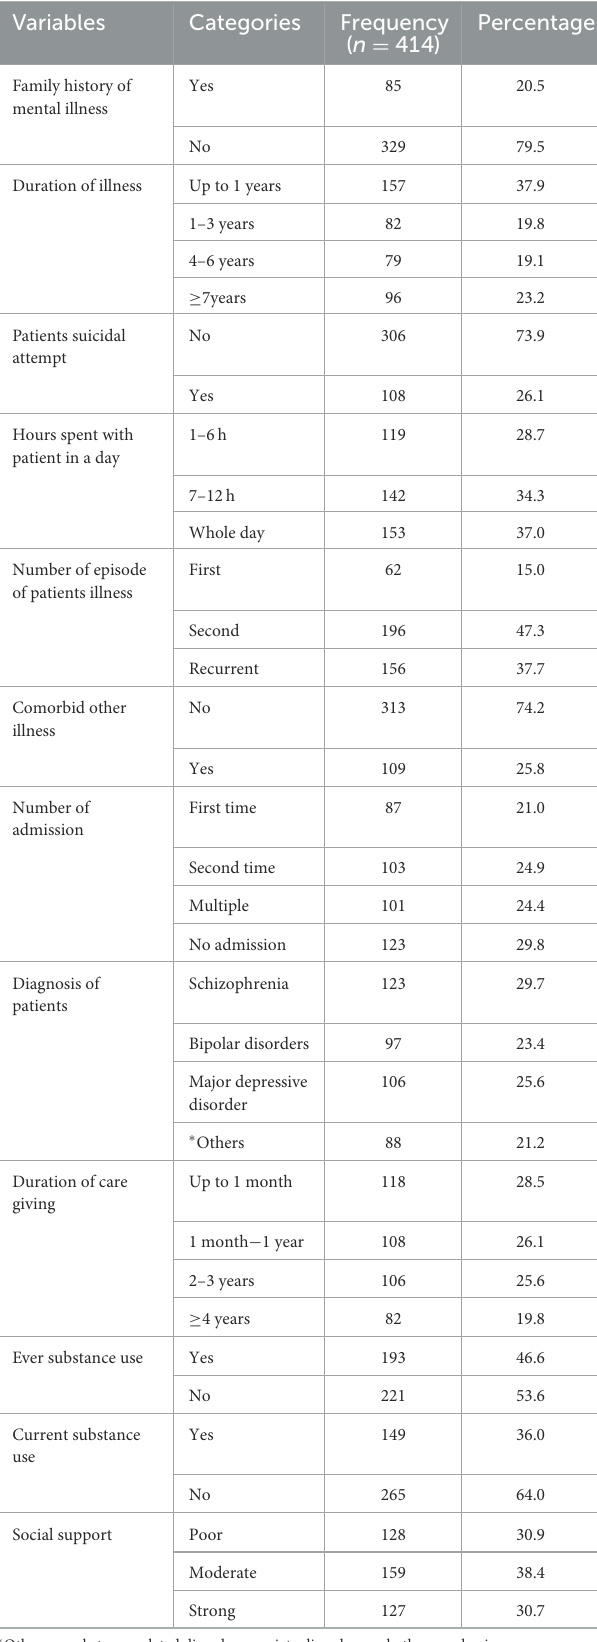
TABLE 2 Clinical, substance use, psychosocial characteristics among primary caregivers of adult patients with mental illness attending at Harari region state public hospitals, Eastern Ethiopia, 2022 ( n =